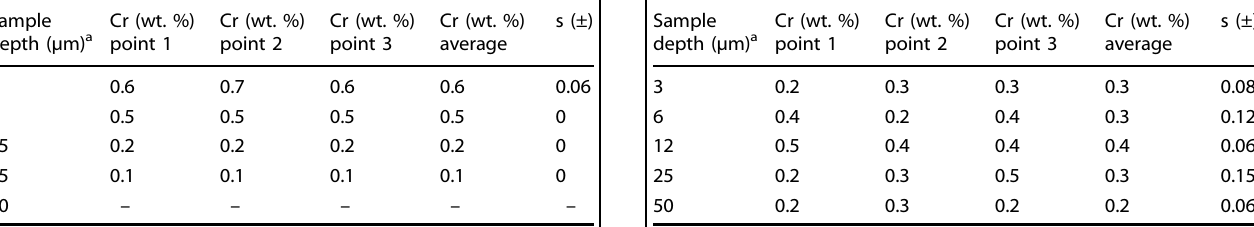
Table 2. Concentration of Cr at different depths of 30TiO 2 fi lm after exposure to Na 2 CrO 4 solution in water/acetone for 24 h at 60 °C.